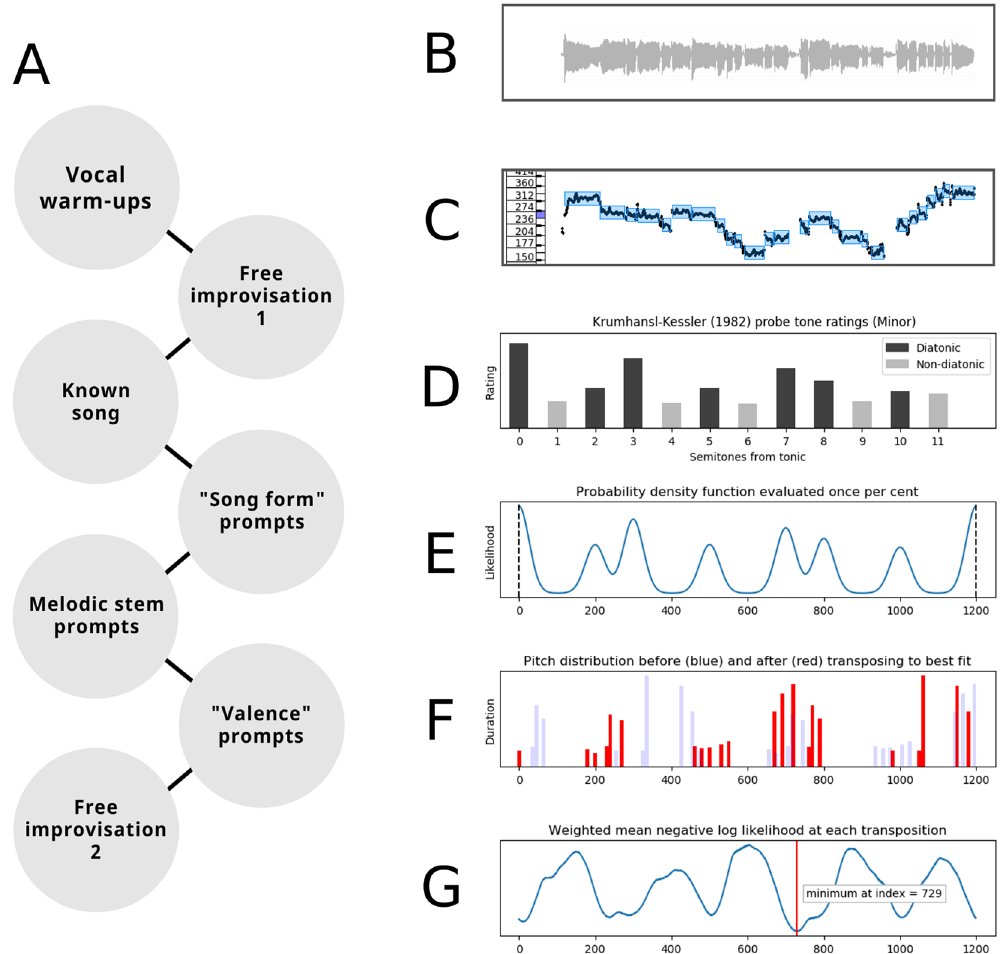
Figure 1. Overview of the task and key-finding algorithm. ( A ) visualizes the general progression of the study. ( B ) visualizes the waveform of an actual improvisation (Audio S1, amusic). ( C ) visualizes the semi-automated annotation of note boundaries (blue boxes) and pitch (black line) in the program Tony. ( D ) visualizes the probe tone ratings (here, minor mode), representing how well each interval fits within the scale, which were used to scale the height and spread of the Gaussians in the normalized probability density function. ( E ) visualizes the normalized probability density function (PDF), which used only the in-scale intervals from ( D ). ( F ) visualizes a histogram of notes from the performance as pitch class in cents (i.e., 0–1200), both in their original value (blue bars) and after being transposed together in steps of one cent, covering the entire octave, until the best alignment with the PDF is found (red bars). By comparing the PDF distribution in ( E ) with the distribution of pitch classes in ( F ), a score of how well the distributions overlap (negative log likelihood) can be calculated for each transposition. ( G ) visualizes the mean negative log likelihood across notes, weighted by note duration, at each transposition. The minimum value indicates the transposition or index with the best fit (vertical red line), which can then be used to locate the tonic to the nearest cent. In short, the algorithm ‘lines up’ the sung notes with the scale as much as possible. The algorithm is visualized dynamically in Supplementary Materials